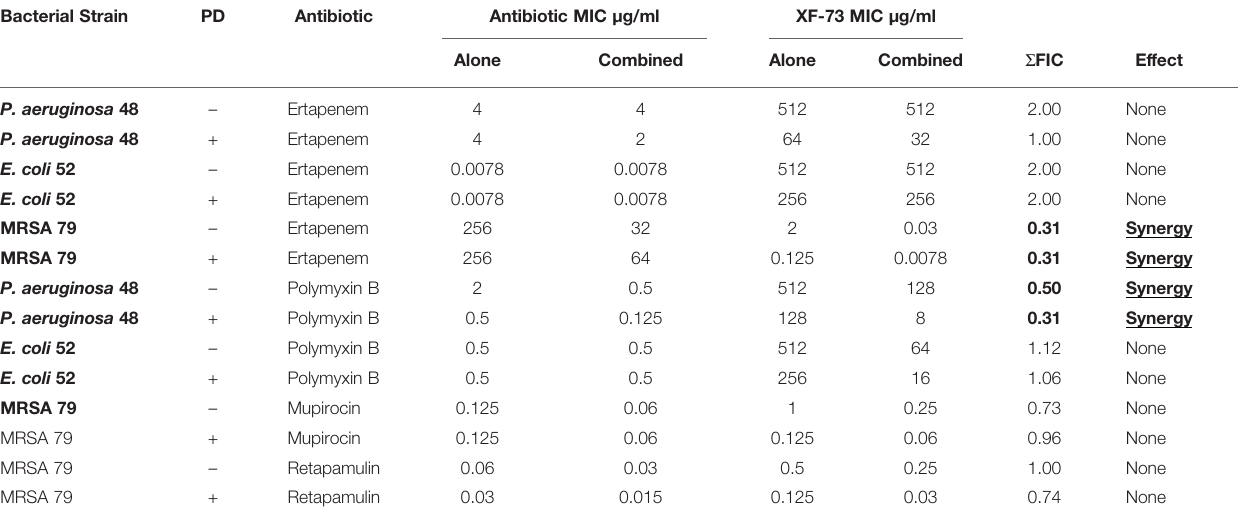
TABLE 2A | Synergistic effects of XF-73 with antibiotics.